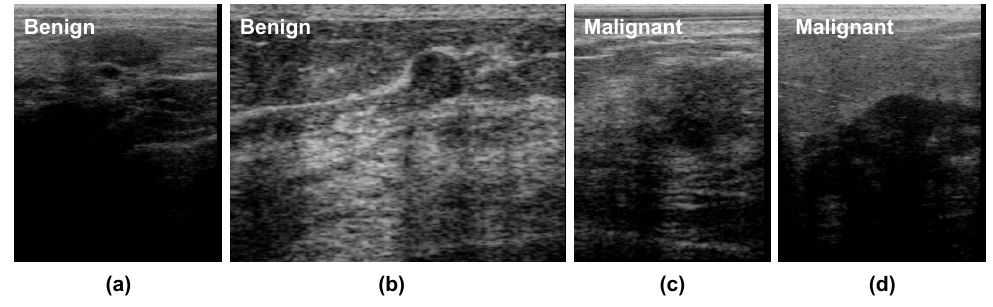
Figure 1. Examples of BUS images for ( a , b ) benign and ( c , d ) malignant cases. They show the presence of artifacts such as speckle noise and the hypoechoic region with shadows caused by the reflection of a high quantity of energy by an enormous impedance discontinuity and a variety of breast tumor shapes and